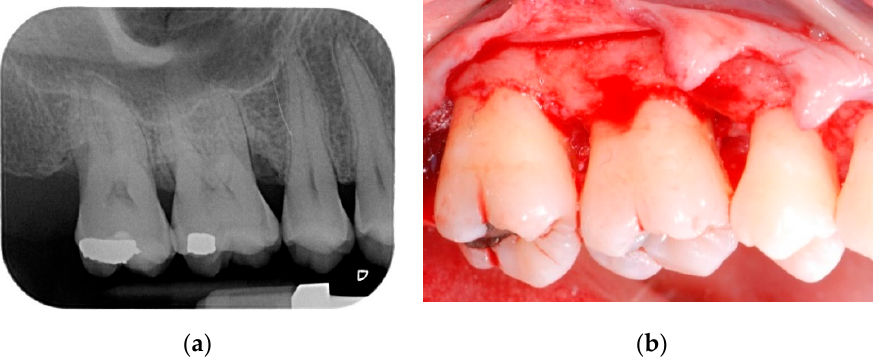
Figure 1. ( a ) Pre-operative periapical radiograph; ( b ) A full thickness flap was elevated in order to get access to the root and the periodontal intrabony defect.